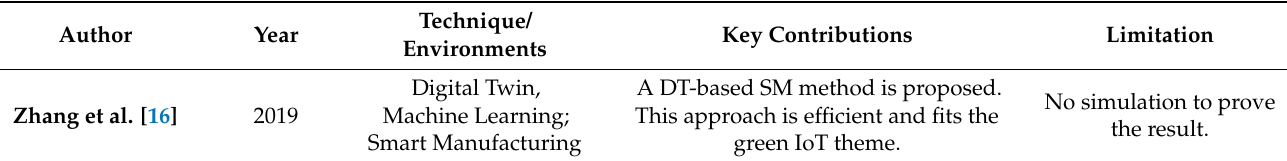
Table 1. Summary of existing